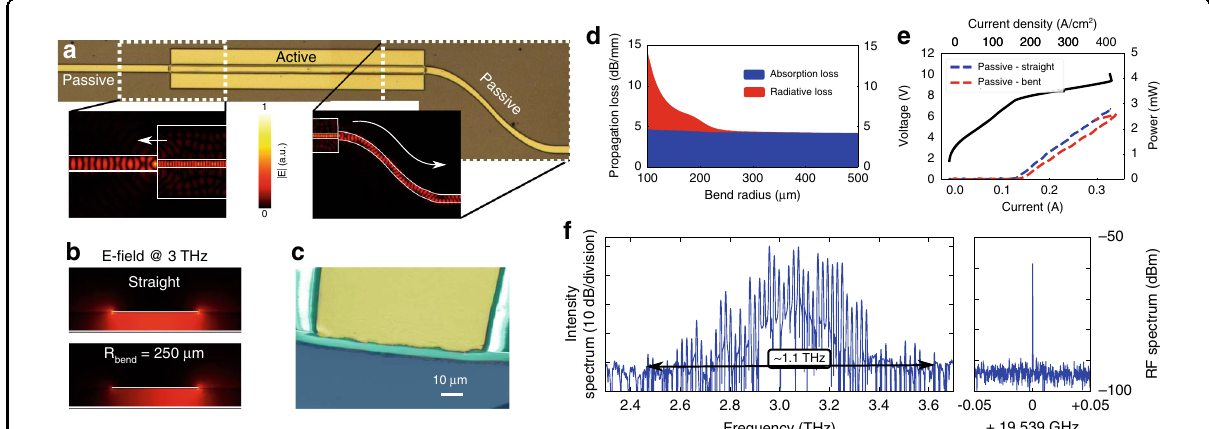
Fig. 6 Simulation and measurement results of passive waveguides co-integrated with active planarized ridge devices. a Optical microscope image of a ridge device co-integrated with straight and curved passive waveguide elements, consisting of a metallized stripe on top of BCB (width 60 μ m, mini-mum bending radius R = 500 μ m). Insets show the simulated THz wave propagation with minimal scattering and bending losses at 3 THz. b Simulated electric fi eld distribution in the passive waveguide cross-section at 3 THz. In the case of a straight waveguide, the intensity is concentrated symmetrically below the metal stripe, while it shifts to the outer side in the case of a bent path. c False color SEM images of the cleaved passive waveguide with a fl at BCB end facet. d Computed passive waveguide propagation losses in dB/mm for a varying bend radius, obtained by COMSOL 2D eigenmode simulations at a frequency of 3 THz. The total losses are split into contributions from absorption loss (overlap with lossy metals and BCB) and radiative loss (bending loss), which is negligible for bend radii above 230 μ m. e The LIVs measured in pulsed (500 ns pulses, 10% duty cycle, 20 K) show an increased threshold current density and a higher slope ef fi ciency, both consistent with the lower end facet re fl ectivity. f Spectrum of a free-running device (CW, T = 20 K) in the comb regime with a bandwidth over 1 THz and a single RF beatnote above − 60 dBm, indicating that the reduced cavity feedback can be bene fi cial for comb